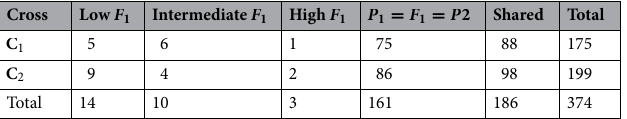
Table 8. Number of GO terms enriched in “Cell Component” (CC) per class.